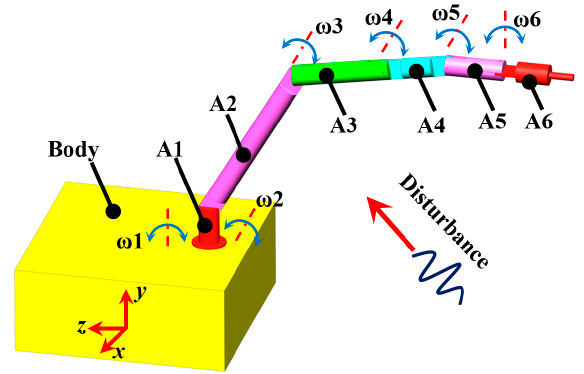
Figure 3. Motion of Joint and Load on UVMS.